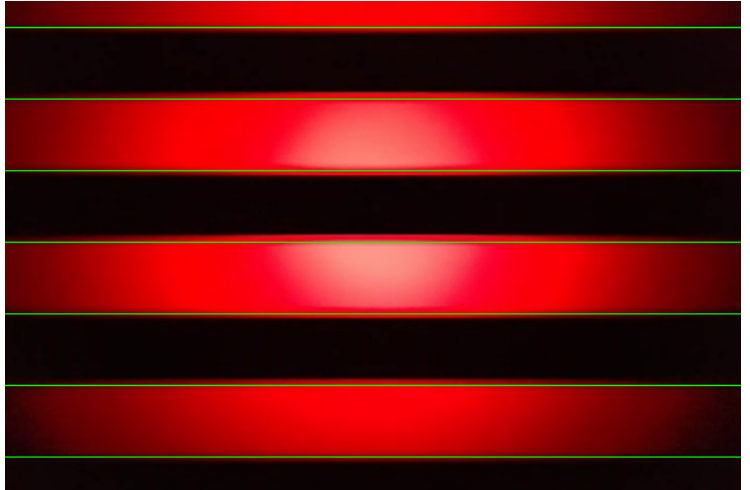
Figure 10. Blooming affecting width of resulting